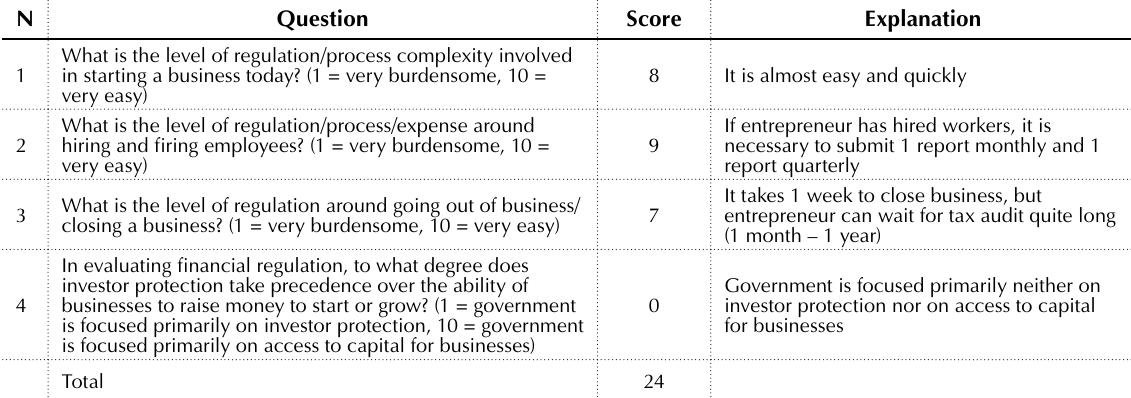
Table 5. Assessing a country’s readiness for crowdfunding: regula�on (C)